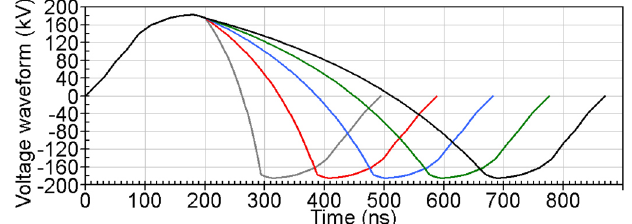
(cid:4) 400 keV , 0 (cid:4) 200 ns (red), t (cid:4) p p (cid:4) 500 ns (black). p